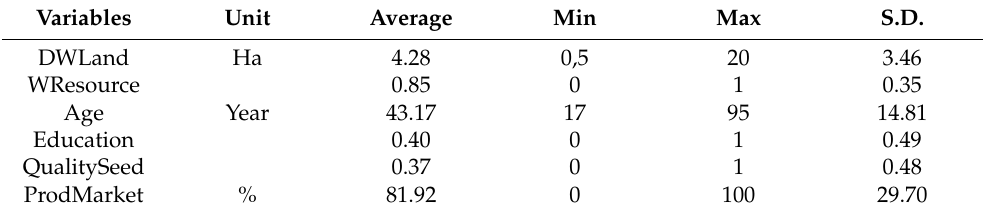
Table 6. Descriptive statistics of explanatory